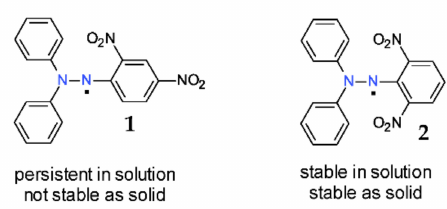
Figure 3. Stability of two hydrazyl